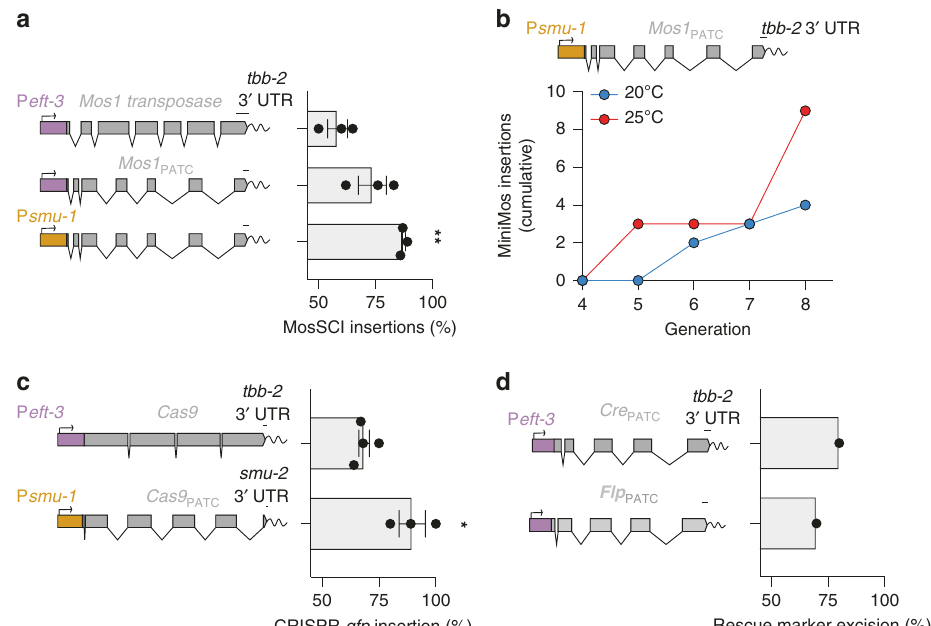
Fig. 7 PATC-rich transgenes mediate ef fi cient gene-editing. a MosSCI insertion frequency of a 4.7 kb gfp transgene at oxTi365 (Chr. V) with a codon- optimized Mos1 transposase containing PATCs and using P eft-3 or P smu-1 . n = 3 biologically independent injections. In all, 20 – 24 animals were used for each set of injections. Kruskal – Wallis one-way ANOVA. Multiple comparisons: Dunnett ’ s test. ** p = 0.0063. b MiniMos insertion frequency over time. Independent transgenic lines carrying arrays with a P smu-1 : mos1 PATC transposase and a miniMos transposon with a 6.0 kb transgene were propagated on ten plates each and screened for insertions in every generation. The lines were propagated in parallel at 25 °C (red line) and 20 °C (blue line). n = 3 biologically independent transgenic lines. c CRISPR/Cas9-mediated GFP tagging of the endogenous his-72 locus 25 using a Cas9 transgene with no PATCs (P eft-3: : Cas9 ) or high PATC content (P smu-2 :: Cas9 PATC ). n = 4 and 3 biologically independent injections (top to bottom). For each injection, 9 – 22 animals were used. Statistics: two-tailed, unpaired t test. * P = 0.013. d Recombinase excision of rescue markers. Strain with single-copy insertions containing a cbr- unc-119 rescue cassette fl anked by either LoxP or FRT sites were injected with a PATC-rich Cre PATC or Flp PATC recombinases, respectively. n = 1 biologically independent experiments were done for each condition. In all, 10 – 11 independently injected animals were scored for each experiment. Five lines were propagated for several generations, and the plates were scored for Unc animals with both copies of cbr-unc-119 removed by recombination. Transgene scale bars = 100 nucleotides. Each datapoint indicates one independent measurement. Bars indicate the mean, and error bars indicate the SEM. Source data are available in the Source Data fi